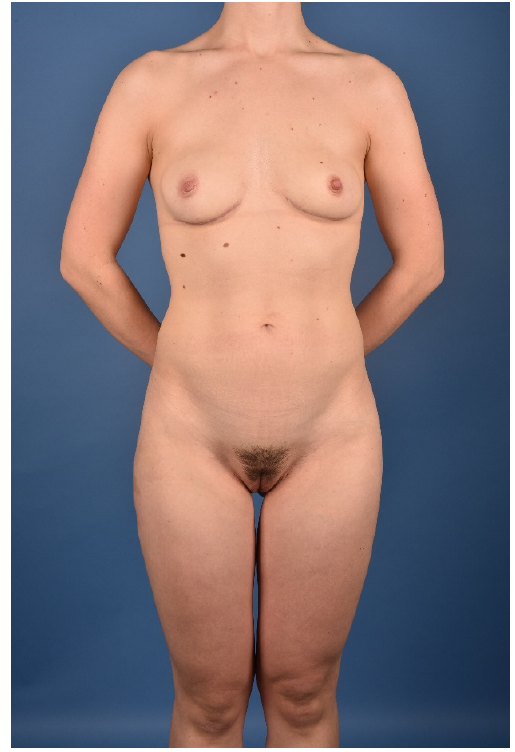
Figure 6. Postoperative image after two-staged bilateral autologous breast reconstruction with free TMG flaps.